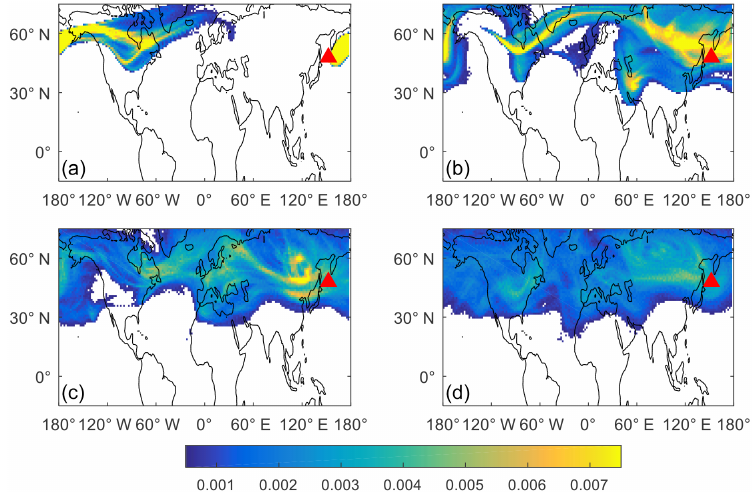
Figure 12. Percentage (%) of air parcels between isentropic surfaces of 360 and 400K on 10 January (a) , 20 January (b) , 31 January (c) , and 10 February 2009 (d) from simulations for a hypothetical eruption of the Sarychev in winter. Results are binned every 2 ◦ in longitude and 1 ◦ in latitude. The red triangle denotes the location of the Sarychev volcano.